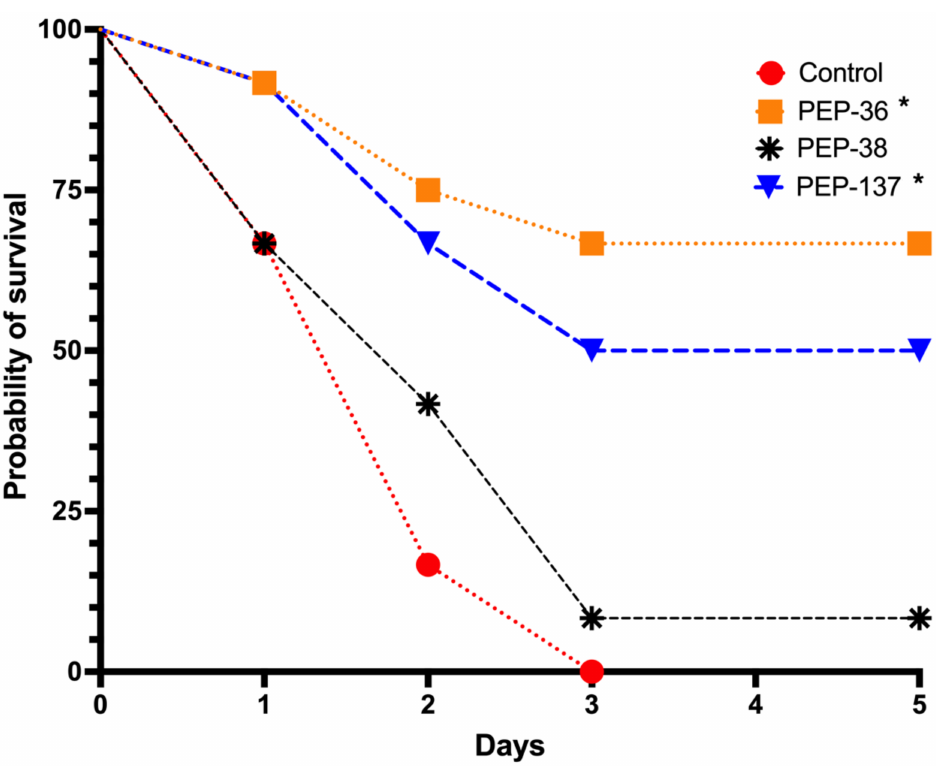
Figure 2. Comparison of probability of survival (%) in each group: control (sterile saline), PEP-36, PEP-38 and PEP-137. The peptides were injected once in a dose of 100 µ g 30 min after infection of mice with 6.75 × 10 8 CFU suspension of a carbapenem-resistant isolate of K. pneumoniae . *—significant differences from the control group using the Kaplan-Meier method and Log-rank (Mantel-Cox)